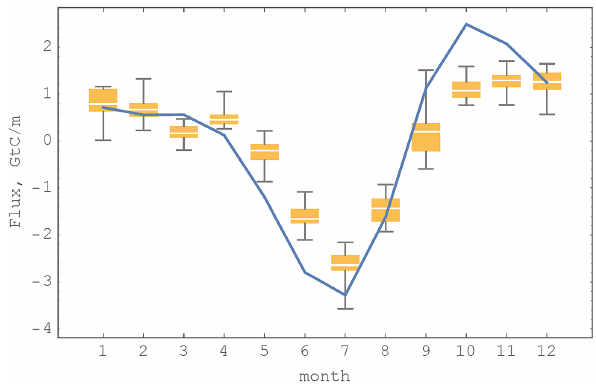
Figure 1. The seasonal cycle of the detrended net carbon exchange between the atmosphere and other pools derived from globally av- eraged monthly surface CO 2 concentrations in 1995–2005 (blue) as compared to the detrended TransCom 3 seasonal CO 2 flux (or- ange) estimated from atmospheric inversions (Gurney and Denning,